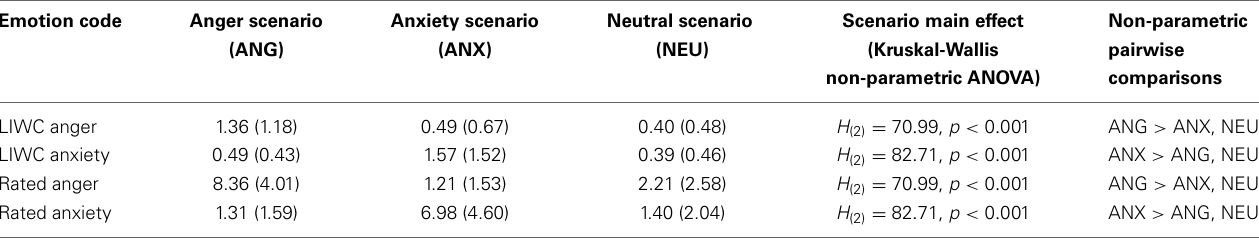
Table 1 | Mean (Standard Deviation) LIWC emotion code scores a and total coder-rated emotion scores for the anger (ANG), anxiety (ANX), and neutral (NEU) ATSS